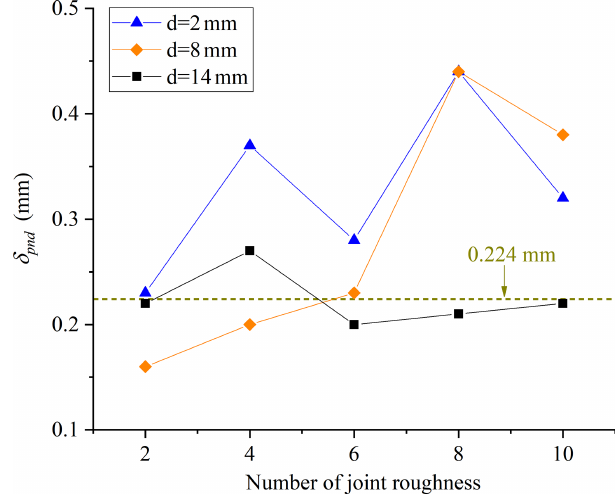
Figure 16. Effect of joint opening on the shearing dila- tancy. Experimental conditions: T =− 5 ◦ C, v = 0.2mmmin − 1 and σ n = 0.5MPa.